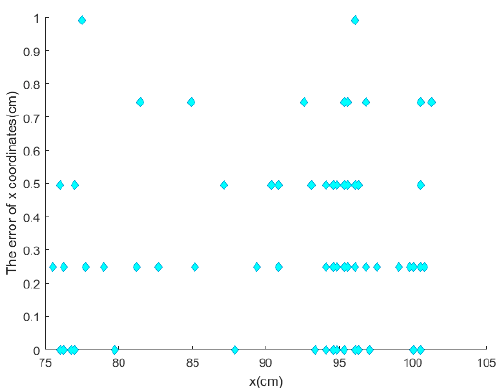
Figure 11. The calculated positioning value and actual positioning value of the positioning terminal. Figure 12. The error of position value of x coordinates. Figure 12. The error of position value of x